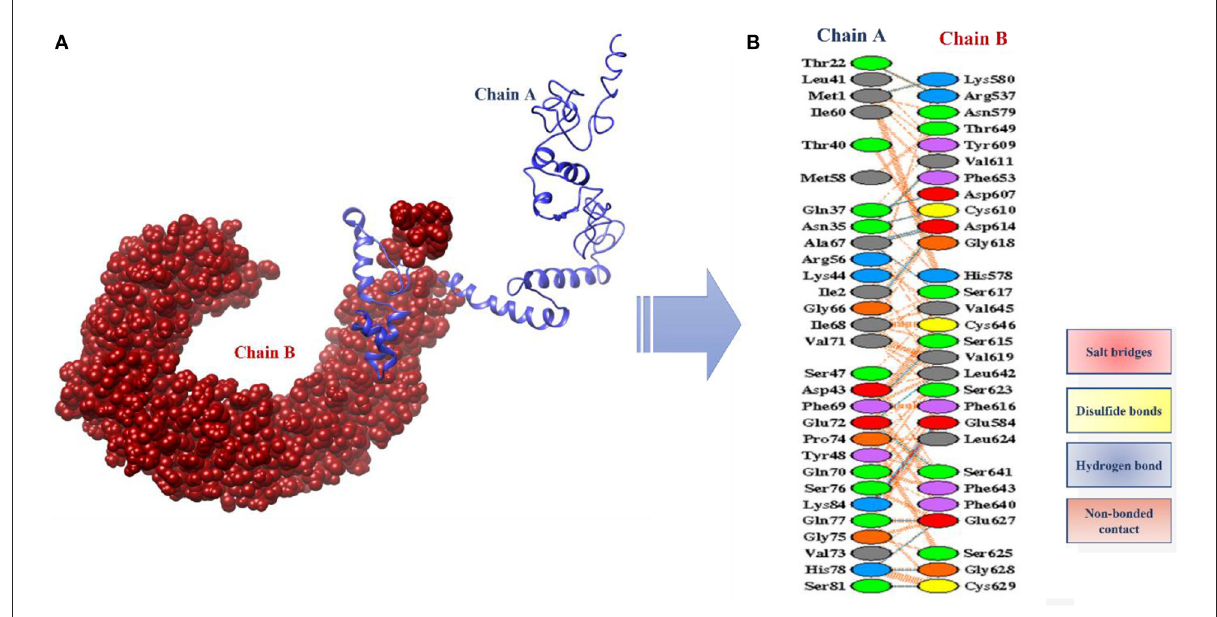
FIGURE10 (A) Docked complex of vaccine model and TLR5 (B) Interactions between the chain A (vaccine) and the chain B (TLR5).